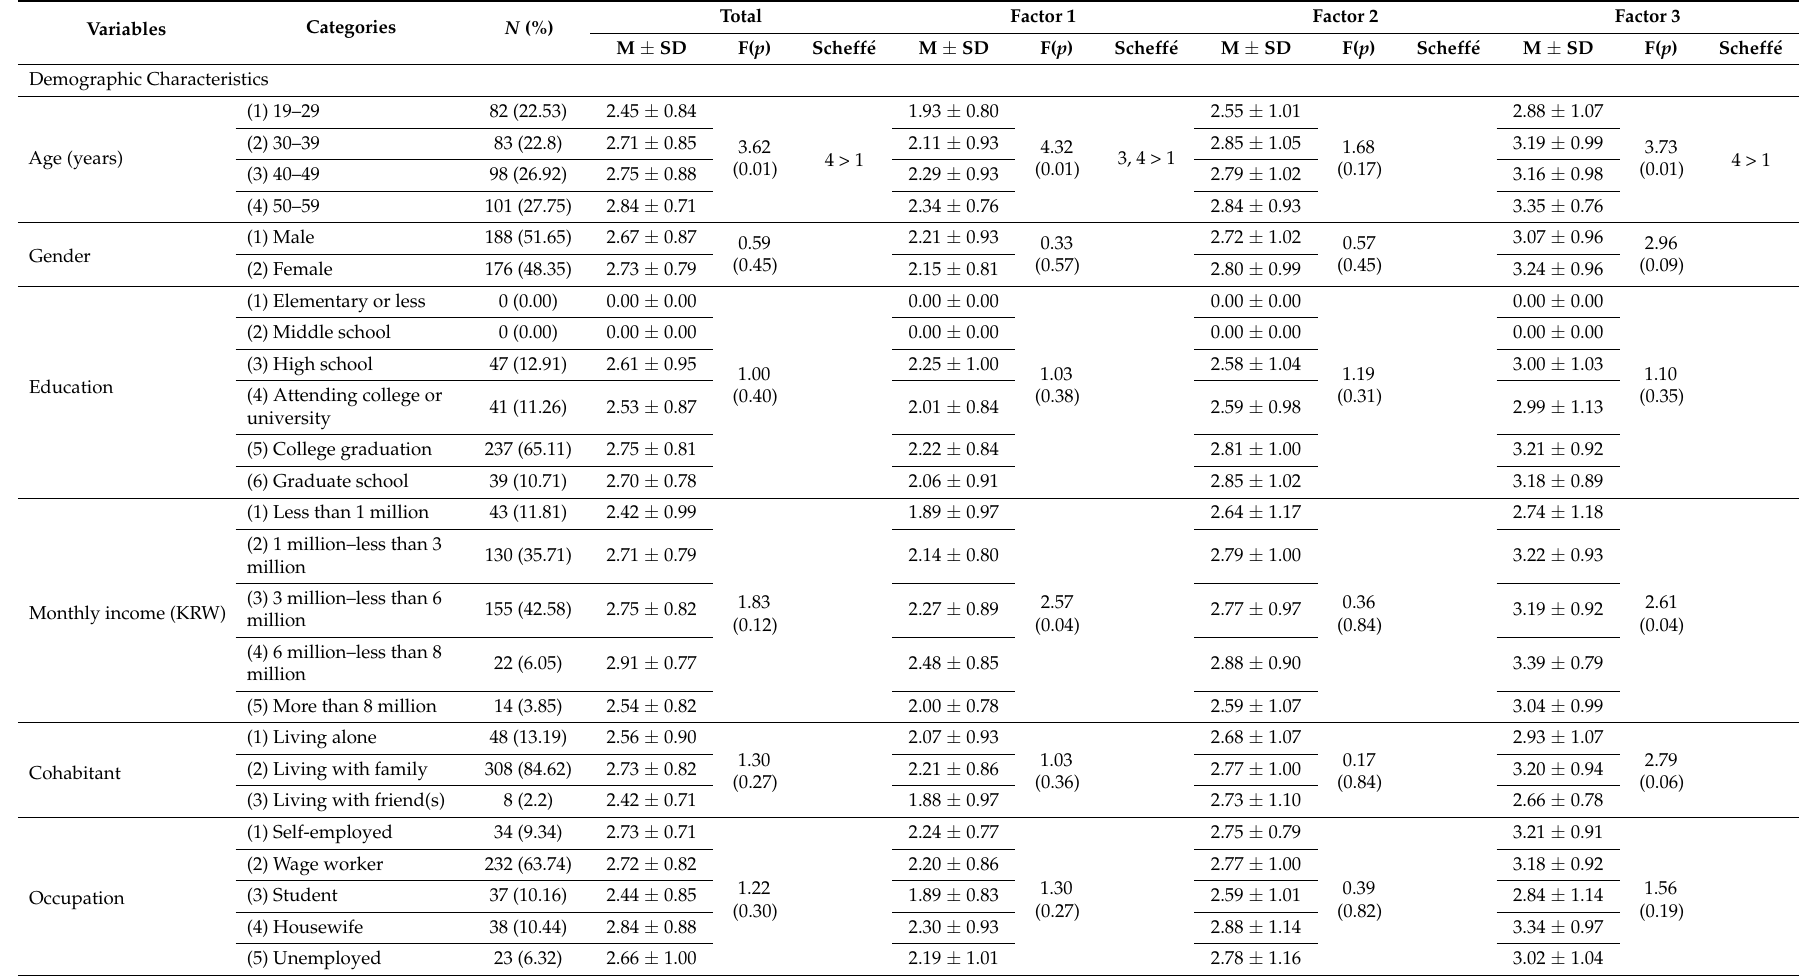
Table 1. Differences of SITMES scores according to participant’s